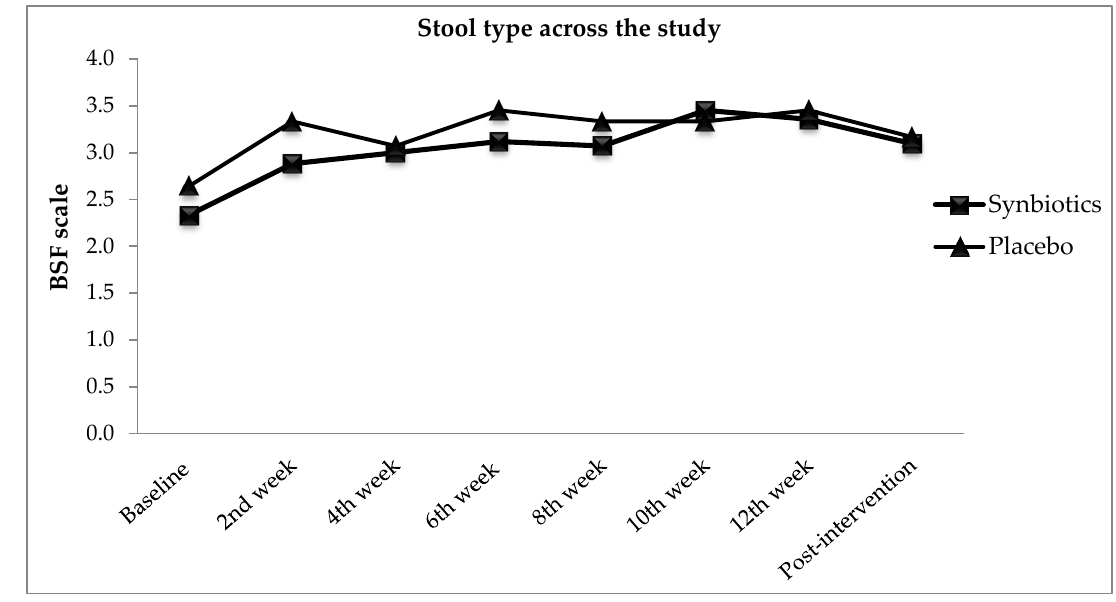
Figure 3. BSF scale from baseline, intervention, and post-intervention.